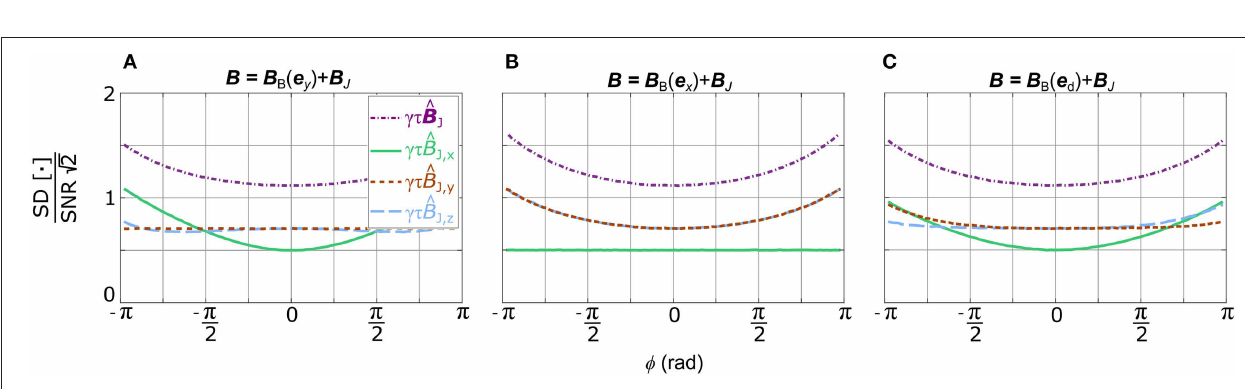
B B e y . B B was adjusted to generate the rotation angles = | | | | e y . The main field B 0 was x -directional. The figures show the standard deviations of reconstructions −